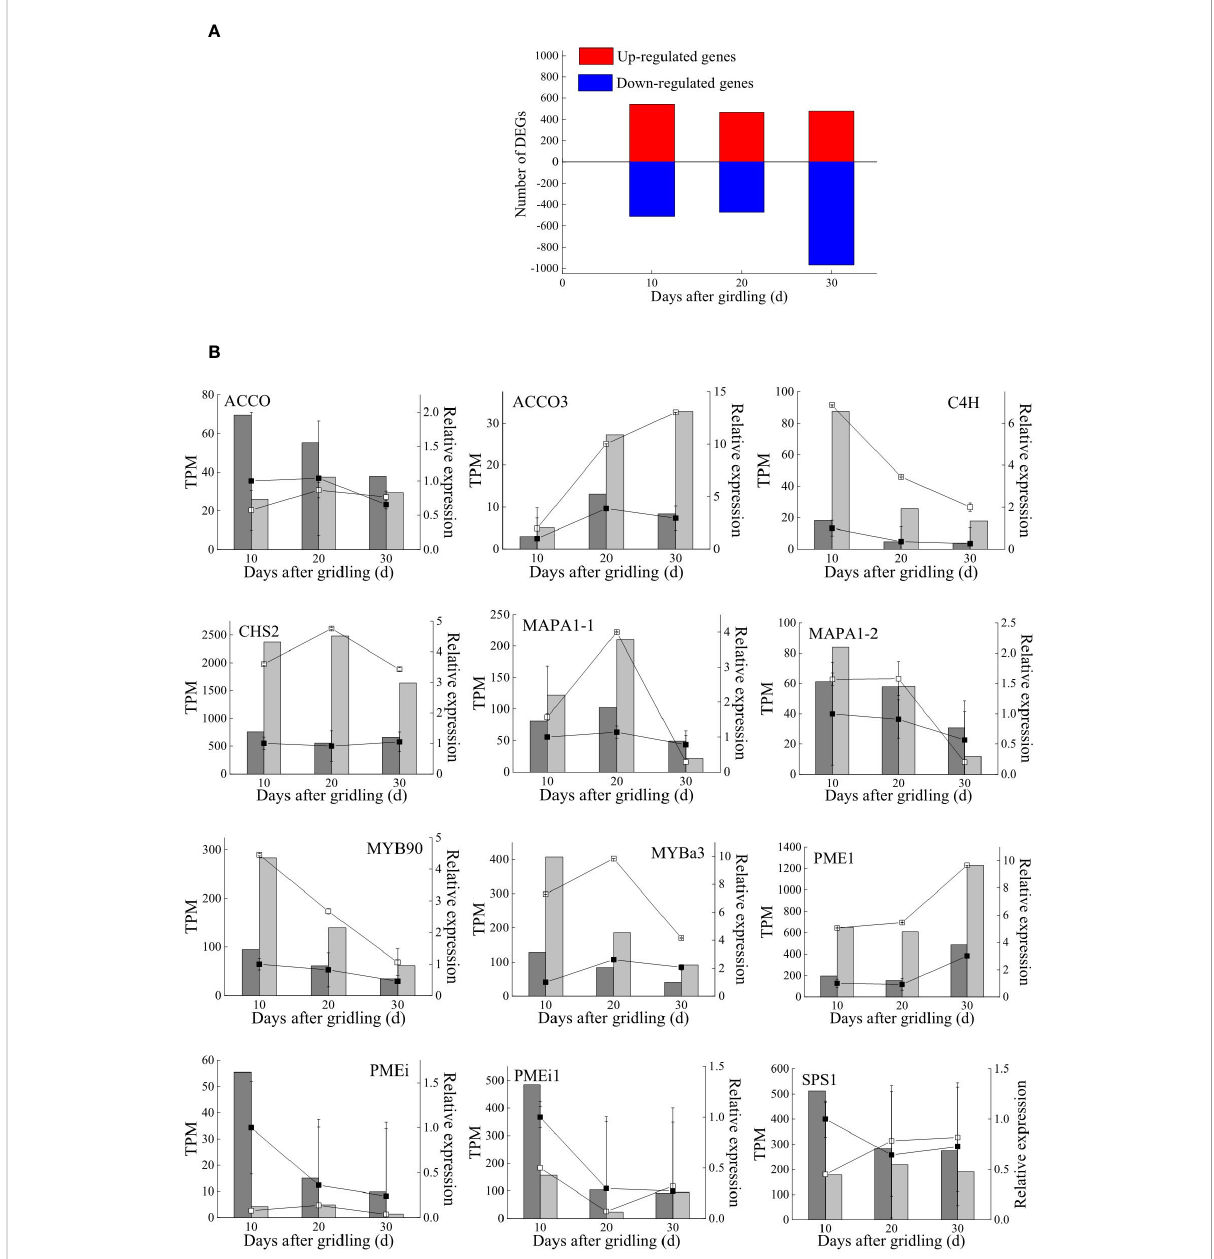
FIGURE 3 DEGs and qRT-PCR validation. (A) Number of DEGs between treatments at three sampling times. (B) Transcriptome validation by qRT-PCR. Gene expression levels of the girdling group (light bars) and control group (dark bars) obtained by RNA-seq are presented as TPM values; gene expression levels in the girdling group (empty squares) and control group (solid squares) obtained by qRT-PCR were normalized to those of glyceraldehyde 3-phosphate dehydrogenase ( GADPH ) expression. ACCO, amicyclopropanecarboxylate oxidase; C4H, trans-cinnamate 4- monooxygenase; CHS, chalcone synthase; MAPA, major allergen Pru ar; MYB, transcription factor MYB; PME, pectinesterase; PMEi, plant invertase/pectin methylesterase inhibitor; SPS, sucrose phosphate